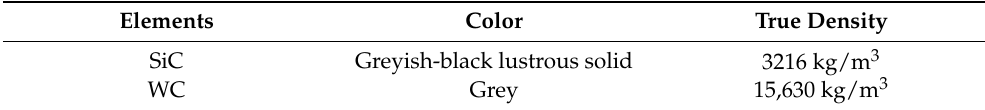
Figure 2. Tungsten carbide ( top ) and silicon carbide ( bottom ). The color and true density (density excluding pores) of silicon carbide and tungsten carbide used in the investigation are presented in Table 2. Table 2. Properties of WC and SiC.